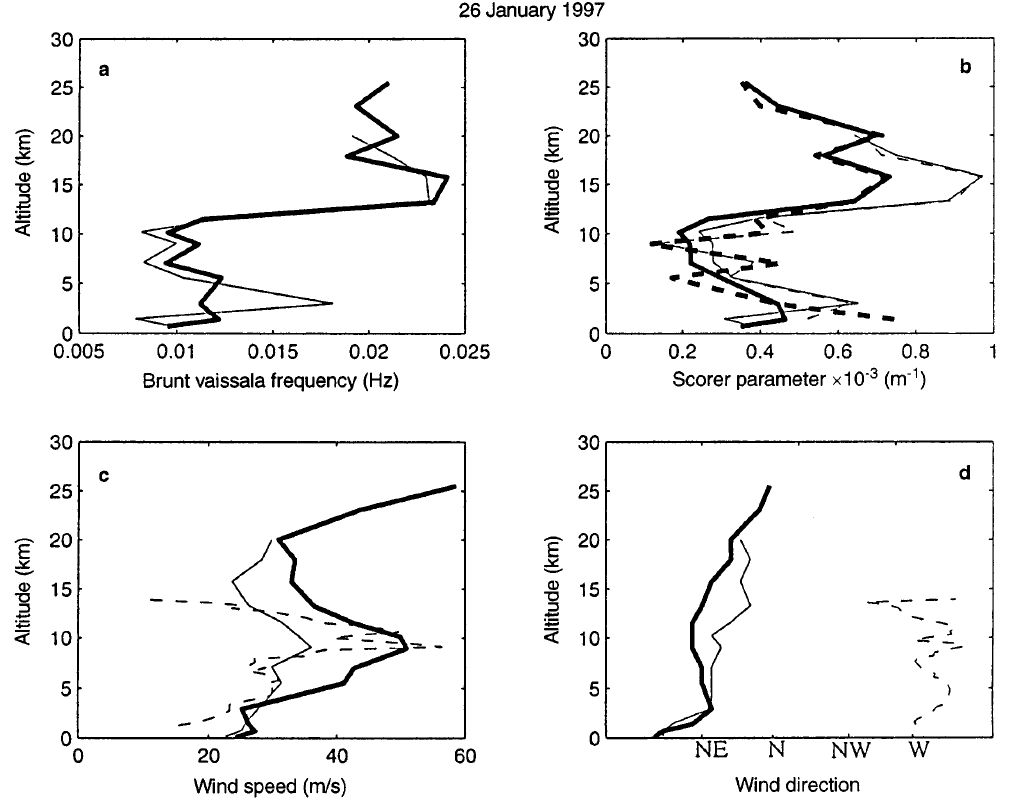
Fig. 12. Profiles for 26 January for 0 UT ( thin line ) and 12 UT ( thick line ) of a Brunt Vaissala frequency from radiosonde from Bodo. b Scorer parameter from radiosonde from Bodo ( solid line : simplified, dashed : full expression, see text). c Wind intensity from radiosonde